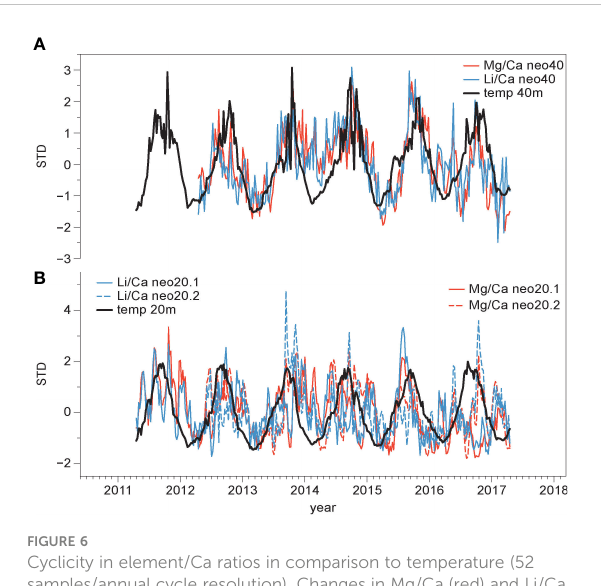
FIGURE 6 Cyclicity in element/Ca ratios in comparison to temperature (52 samples/annual cycle resolution). Changes in Mg/Ca (red) and Li/Ca (blue) ratios and in situ measured temperature data (black). (A) 40 m water depth, (B) 20 m water depth. Values shown are standardized by removing mean and dividing by standard deviation